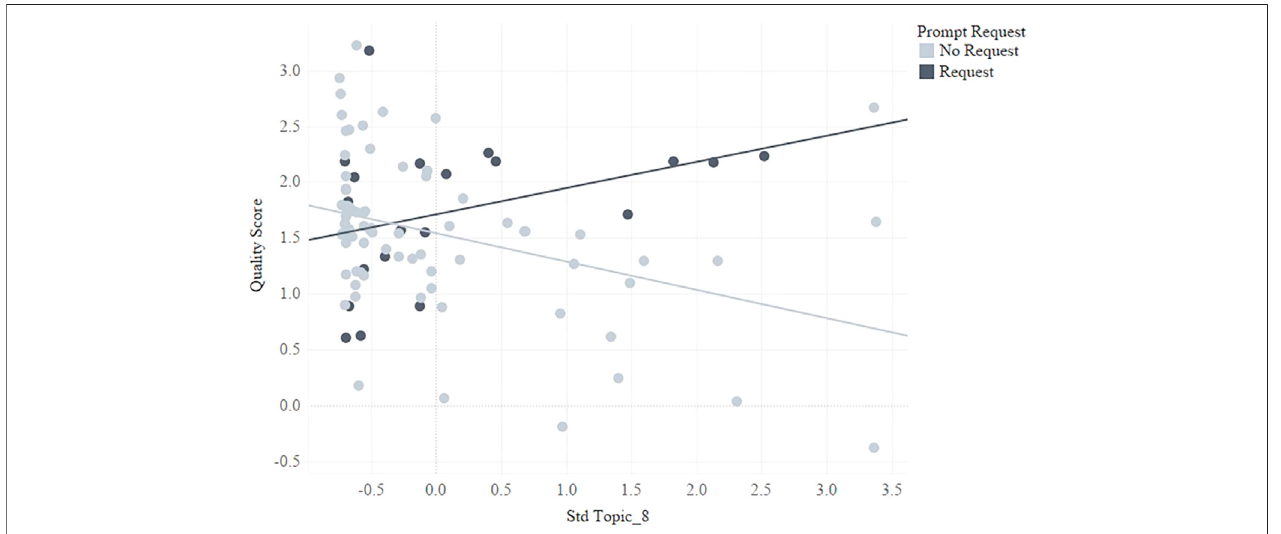
FIGURE 5 | Quality of lesson plan edits across prompt request and no-request with topic mixture as a covariate.